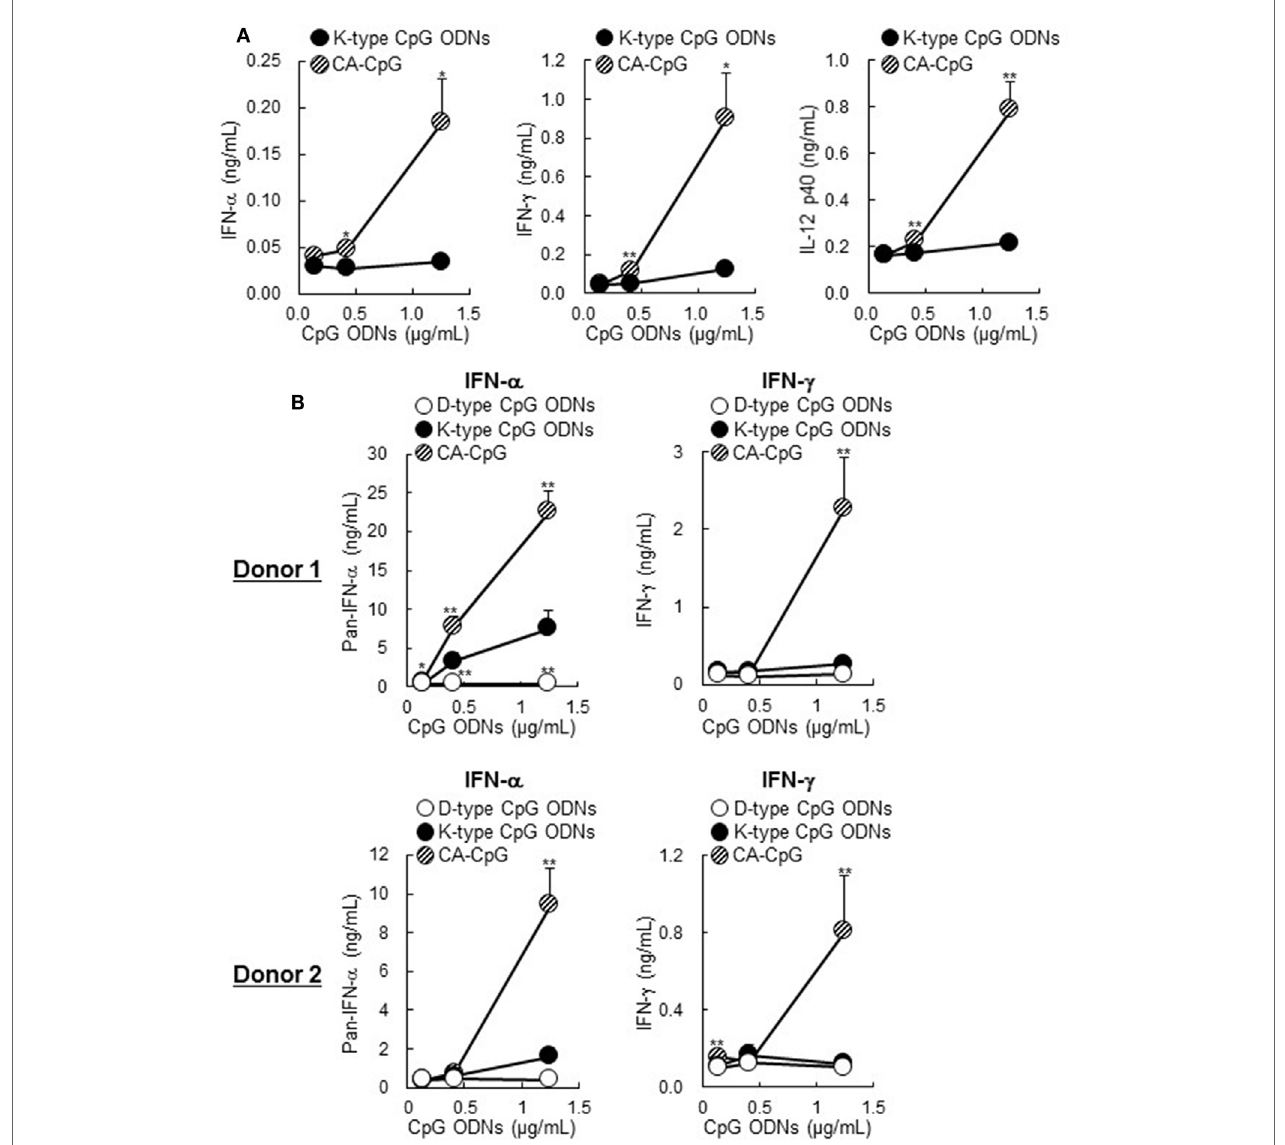
FigUre 2 | Cytokine production induced by carbonate apatite (CA)-cytosine-phosphate-guanine (CpG) in mouse-derived dendritic cells (DCs) and human peripheral blood mononuclear cells (PBMCs). Mouse-derived DCs (a) and human PBMCs (B) were treated with several concentrations (adjusted for CpG oligodeoxynucleotides (ODN) concentration) of CA-CpG, K-type CpG ODNs, or D-type CpG ODNs for 24 h , and the cytokine concentrations in the supernatants were then measured by ELISA. (a) In DCs, CA-CpG induced higher IFN- α , IFN- γ , and IL-12 p40 production than did K-type CpG ODNs, n = 4 per group. (B) In PBMCs, CA-CpG induced higher levels of pan-IFN- α and IFN- γ production than did K-type or D-type CpG ODNs, n = 5 per group. These data suggest that CA-CpG has some characteristics of D-type CpG ODNs. Data are given as mean ± SD. * p < 0.05, ** p < 0.01 vs. K-type CpG ODN-treated group as indicated by Student’s t -test (a) or Dunnett’s test (B)